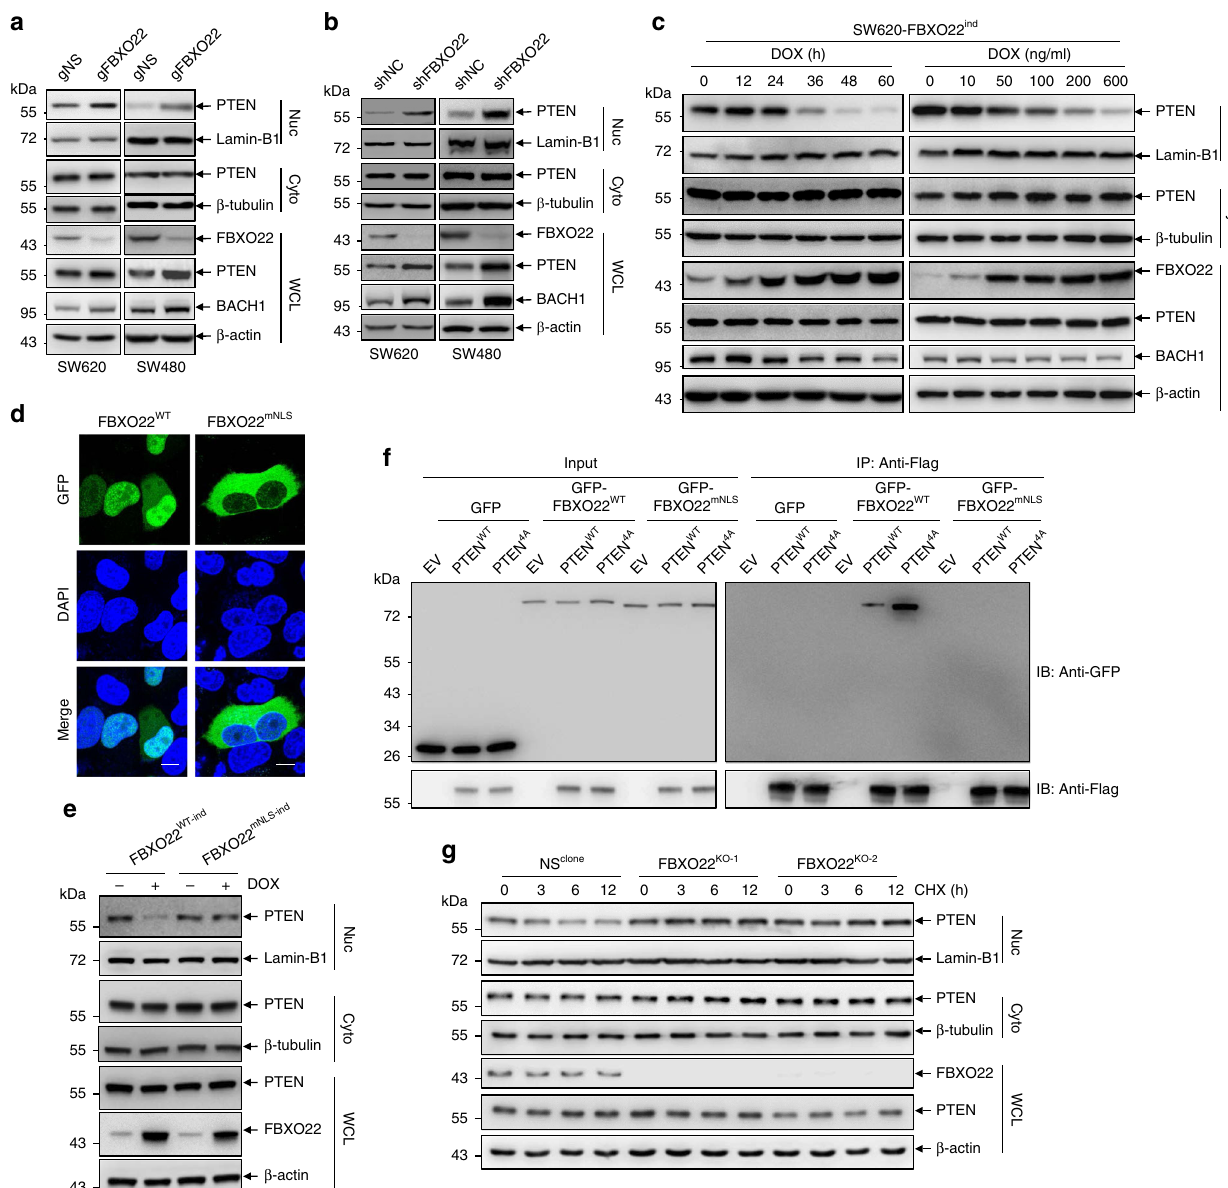
Fig. 3 FBXO22 destabilizes nuclear but not cytoplasmic PTEN. a , b Western blots of indicated proteins in the nuclear (Nuc) and cytoplasmic (Cyto) fractions as well as whole-cell lysates (WCL) of SW620 or SW480 cells transduced by lentiviruses encoding CAS9 and gFBXO22, along with gNS as a non-speci fi c control ( a ), and retroviruses encoding a shRNA targeting FBXO22 (shFBXO22), along with shNC as a negative control ( b ). c A doxycycline (DOX)-inducible expression system encoding FBXO22 was introduced by lentiviruses into SW620 cells (SW620-FBXO22 ind ). Western blots of indicated proteins in the nuclear and cytoplasmic fractions as well as whole-cell lysates of SW620-FBXO22 ind cells by DOX administration for indicated times (left) or concentrations (right). d Representative images of GFP-tagged FBXO22 WT and FBXO22 mNLS in Hela cells with re-staining of DAPI. Scale bar represents 10 μ m. e A DOX-inducible expression system encoding FBXO22 WT or FBXO22 mNLS was introduced by lentiviruses into SW620 cells (SW620-FBXO22 WT-ind or SW620-FBXO22 mNLS-ind ). After DOX administration, cells were fractionated and subjected to Western blots of indicated proteins. f 293T cells co-transfected with GFP, GFP-FBXO22 WT or GFP-FBXO22 mNLS and Flag-tagged PTEN WT or PTEN 4A were subjected to immunoprecipitation with an anti-Flag antibody. Western blots of Flag- and GFP- tagged proteins in the immunoprecipitates are shown. g Western blots of indicated proteins in the nuclear and cytoplasmic fractions as well as whole-cell lysates of two clonally derived 293T cell lines depleted of FBXO22 (FBXO22 KO-1 and FBXO22 KO-2 ) and a negative control (NS clone ) respectively treated with 50 μ g/ml CHX for hours as indicated. The experiments shown in a – g were repeated three times with similar results, and the results of one representative experiment are shown. Source data are provided as a Source Data fi proteins through APC/C – CDH1. Inducible expression of PTEN regulates the ef fi ciency of alternative splicing of cancer- FBXO22 also increased the expressions of PLK1 and Aurora A related genes, including GOLGA2, whose splicing promotes Golgi in LS174T cells, but the effect on Cyclin A2 was mild, probably extension and secretion 20 . We thus tested whether FBXO22 also due to the high basal level of Cyclin A2 in this cell line plays a role in alternative splicing. For this purpose, the pTWT (Supplementary Fig. 4e). Previously, we reported that nuclear minigene which contains α -tropomysin ( α -TM) exons 1, 3, and